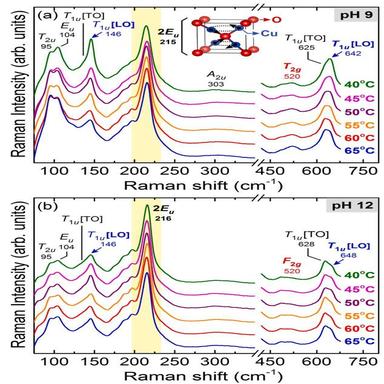
Raman spectrum of Cu2O thin films electrodeposited at (a) pH 9 and (b) 12 in different bath temperatures. The spectra were acquired at room temperature and are normalized by the integrated area of the 2Eu vibrational mode. The spectra are vertically displaced for better visualization.